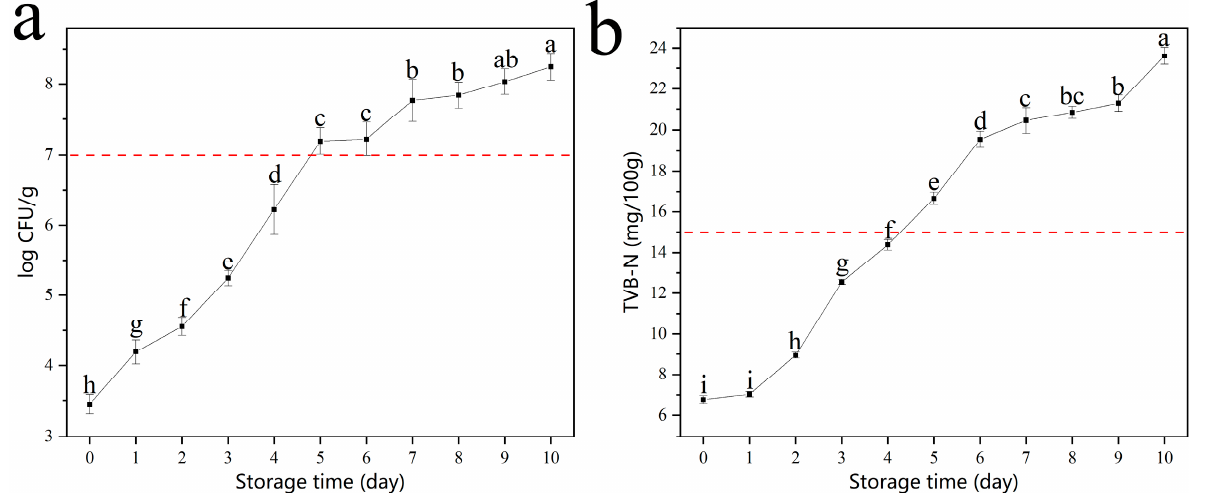
Figure 5. Changes in ( a ) TVCs and ( b ) TVB-N in chilled broiler meat in vacuum-packaged conditions stored at 4 °C. Vertical bars represent standard deviation of the mean ( n = 6). Different lowercase letters indicate significant differences at different storage times ( p < 0.05).